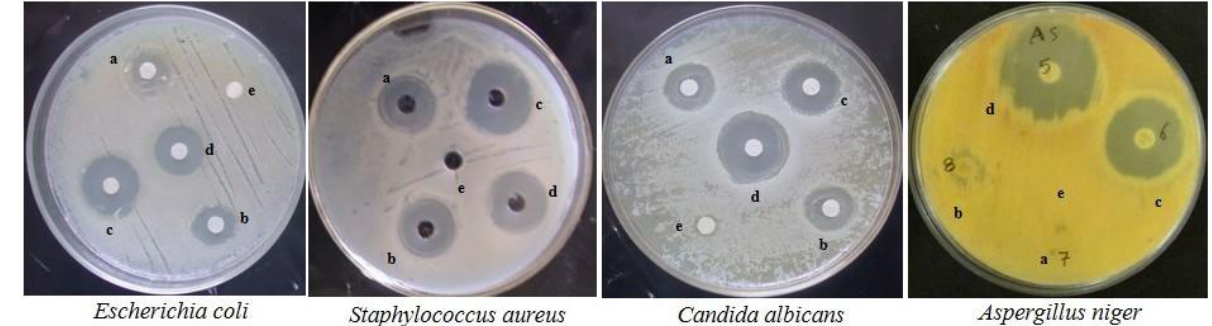
Figure 7. Antimicrobial activity of compound 9b against common bacterial pathogens. a: 50 µL, b: 75 µL, c: 100 µL, d: positive control, e: negative control.